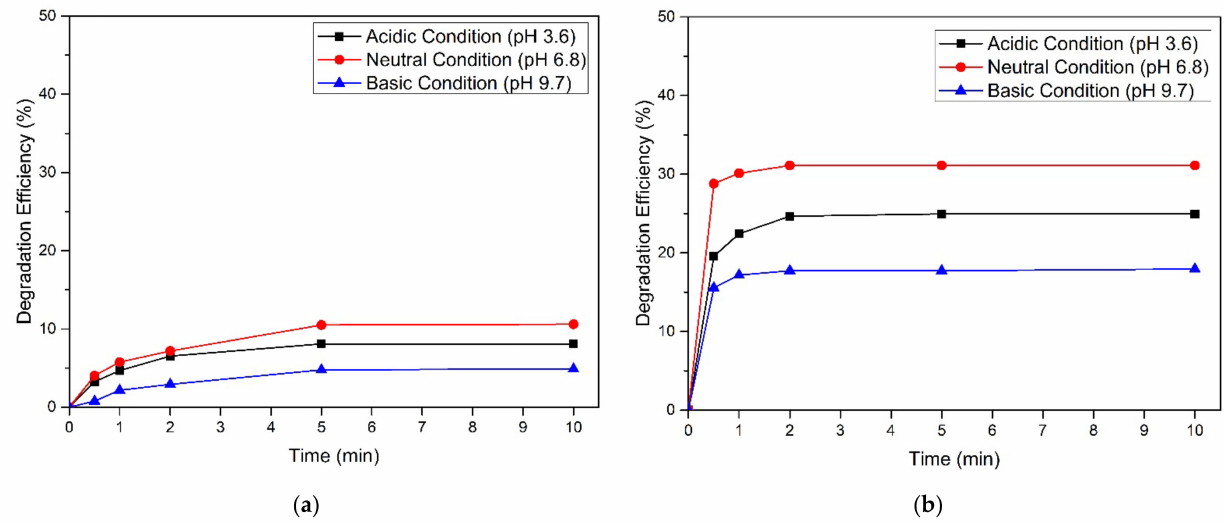
Figure 3. Effect of initial pH on the removal of ( a ) bromobenzene and ( b ) chlorobenzene. (Experimental conditions: C o = 0.010 mM, [FeO 42 − ] = 0.010 mM, temperature = 25 ◦